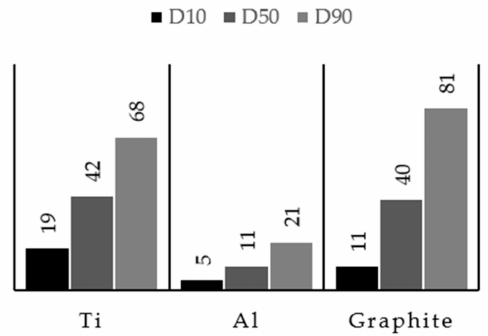
Figure 4. Particle size distribution (D 10 , D 50 , and D 90 ) of starting powders. Data were collected from dynamic light scattering (DLS)